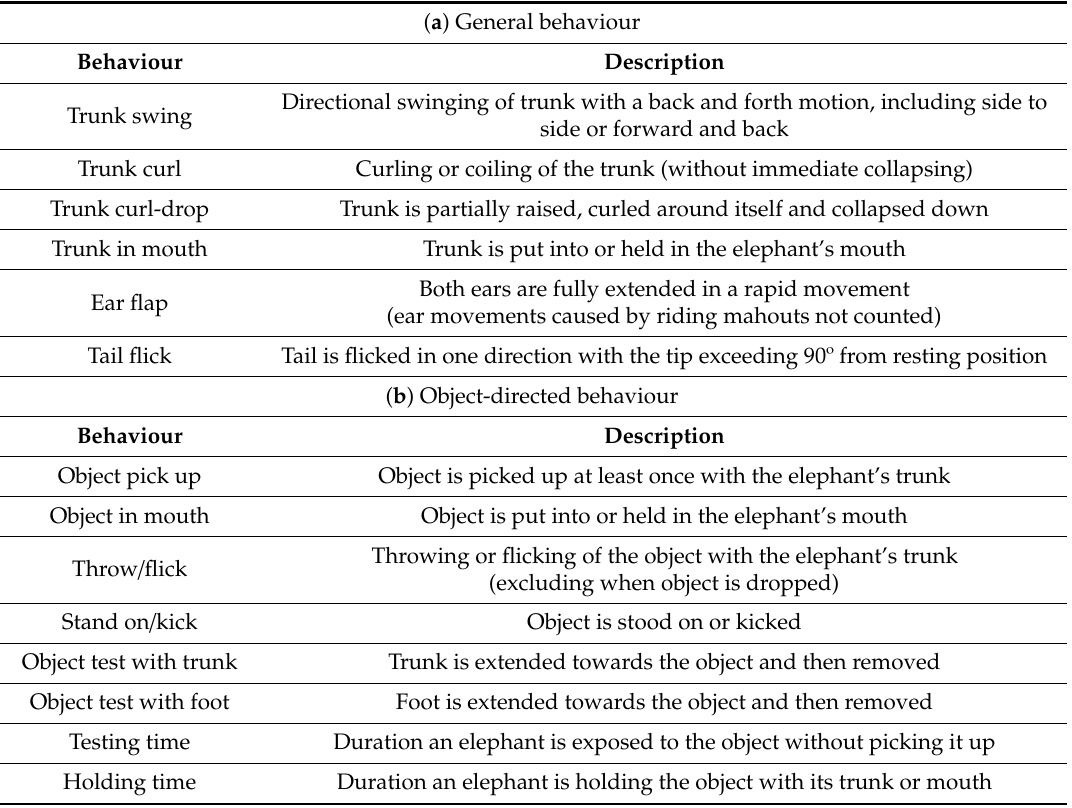
Table 1. Ethogram of Myanma Timber Enterprise (MTE) elephant behaviour during the object pick up